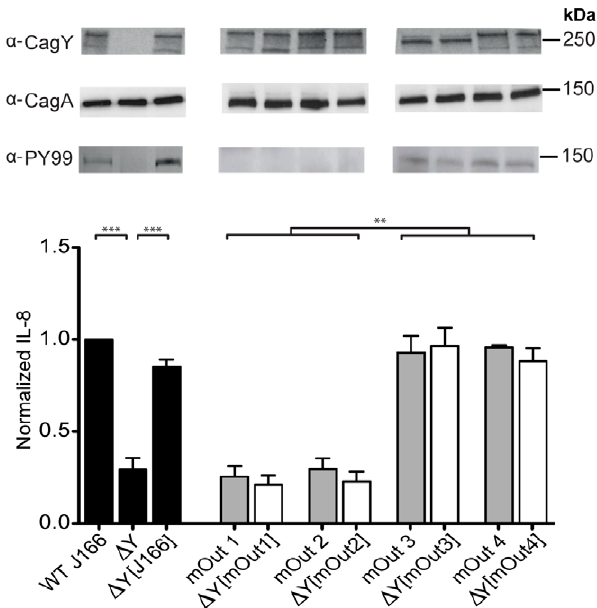
Figure 4. Recombination in cagY during infection of mice is sufficient to reduce the capacity of H.pylori to induce IL-8 and translocate CagA. Deletion of cagY ( n Y) from WT H. pylori J166 significantly reduced its capacity to induce IL-8 (mean 6 SEM of 3 replicates), which was recovered when the chromosomal WT cagY allele was restored ( n Y [J166]) by complementation (black bars). Two output strains from C57BL/6 mice with unique cagY alleles (mOut1, mOut2) lost the capacity to induce IL-8 (gray bars) and translocate CagA, although they expressed CagY ( a -CagY). Complementation of n cagY with cagY from mOut1 ( n Y [mOut1]) or mOut2 ( n Y [mOut2]) recapitulated their lack of IL-8 induction (white bars) and translocation of phosphorylated CagA ( a -PY99). Similarly, replacement with cagY from two output strains (mOut3, mOut4) that expressed a unique cagY but maintained the capacity to induce IL-8 (gray bars) and translocate CagA, also phenocopied their IL-8 induction and translocation of CagA. All strains expressed CagA ( a -CagA), though only those that induced IL-8 had the capacity to translocate CagA that was tyrosine phosphorylated. Multiple bands in the CagY immunoblot could represent different transcription or translation products, or even protein fragments, but they are CagY- specific since they are absent in the cagY deletion mutant. ** P , 0.01; *** P , 0.001.